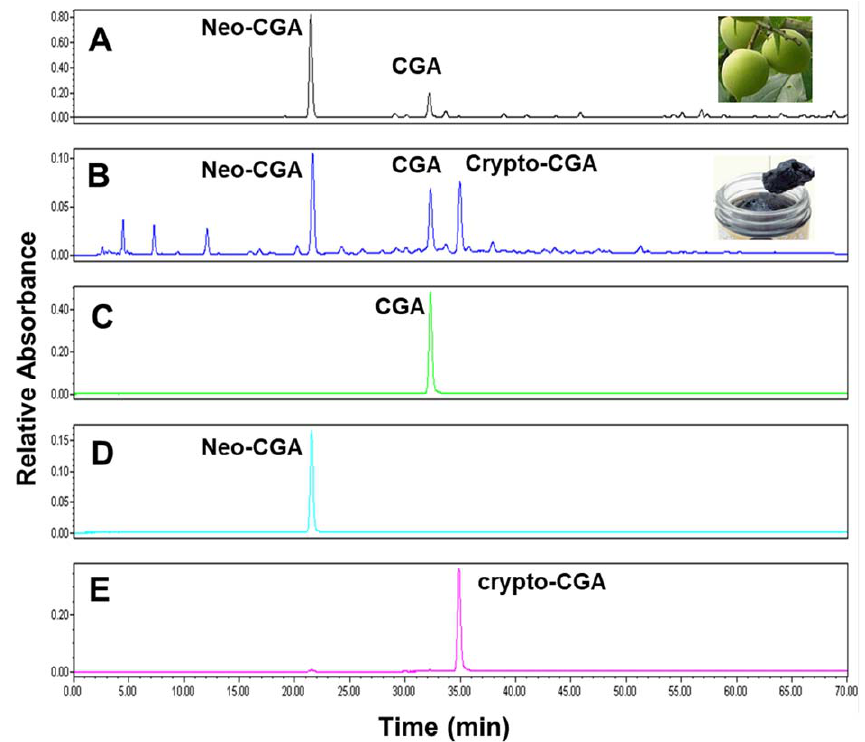
Figure 1. HPLC profiles (detected at 320 nm) of the chemical constituents in fresh juice of Prunus mume fruit ( A ) and mei extract ( B ). Three major peaks, neochlorogenic acid (neo-CGA), chlorogenic acid (CGA), and cryptochlorogenic acid (crypto-CGA) are labeled. Authentic standard compounds of CGA, neo-CGA, and crypto-CGA are shown in ( C – E ). The chemical structures of the three chlorogenic acid isomers were further verified by comparison with mass spectrometry data reported formerly (Figure 2) [15,16]. Their UV absorption spectra showed a maximum wavelength at 323.2 nm, and ESI ‐ MS in neg ‐ ative ion mode yielded [M − 1] − at m / z 353. The product ions of [M − 1] − gave diagnostic fragmentation patterns to distinguish the chlorogenic acid isomers. The peak at 22 min was assigned as neochlorogenic acid by fragmentation m / z 353 in MS1 and m / z 173.0, 179.0, and 191.0 in MS2, where m / z 191.0 was predominant, and m / z 179.0 had a relative intensity above 75% of the base peak. The peak at 33 min was assigned as chlorogenic acid by m / z 353 in MS1 and m / z 191 in MS2. The peak at 35 min was assigned as crypto ‐ chlorogenic acid by m / z 353 in MS1 and m / z 173.0, 179.0 and 191.0 in MS2, where the fragment ion at m / z 173.0 was in the highest abundance, and m / z 179.0 showed a relative intensity above 70% of the base peak.